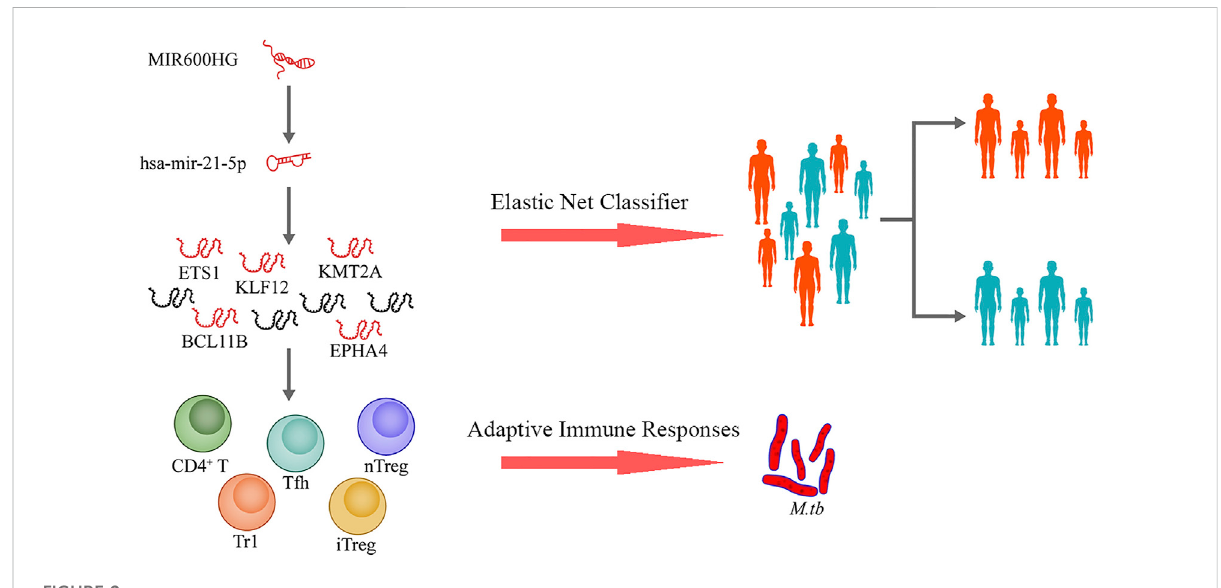
FIGURE 2 Proposed scheme for this